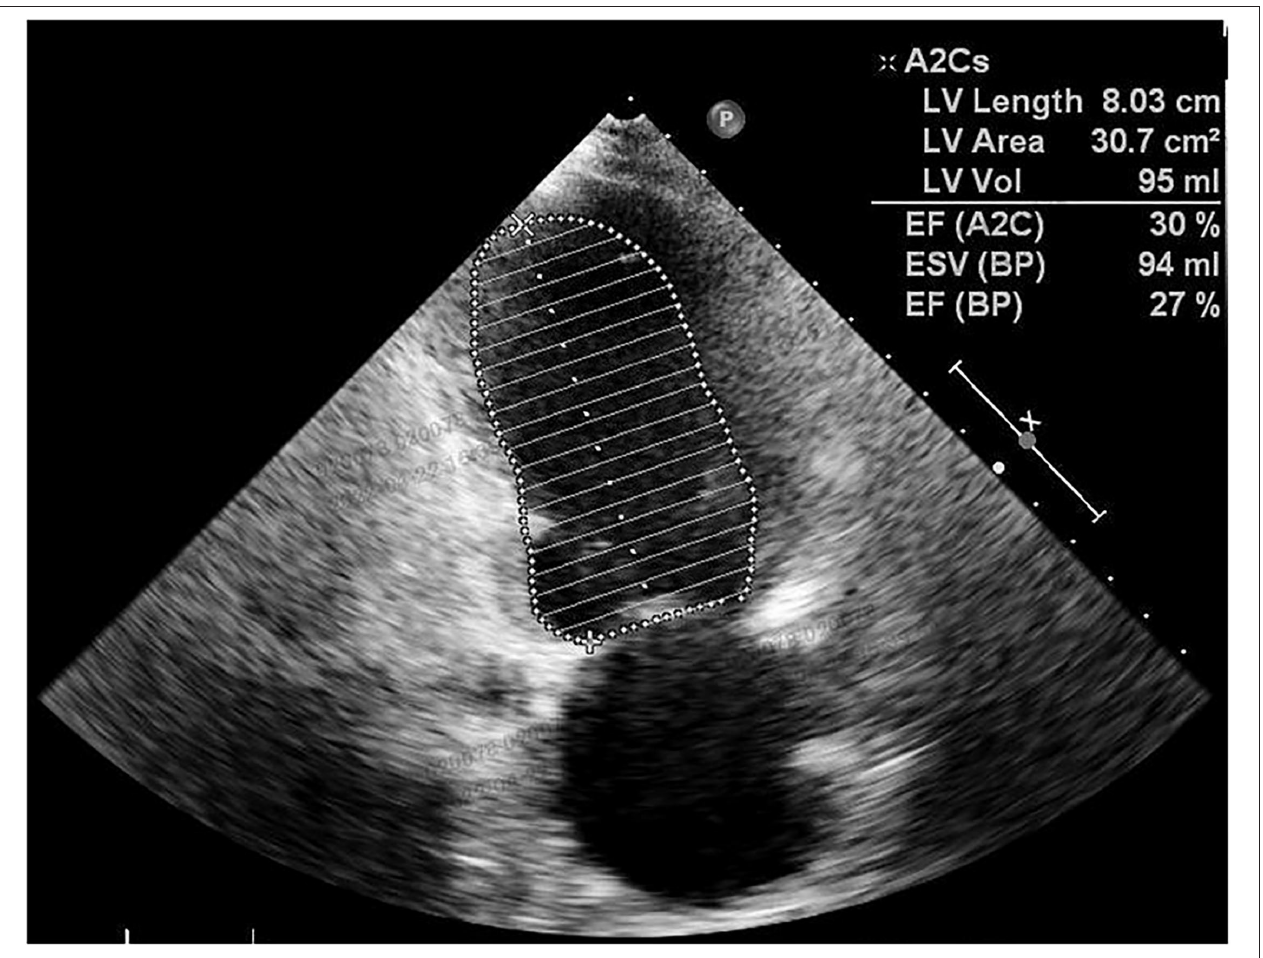
FIGURE 3 | Echocardiography performed on a postoperative Day 4 showed a remarkable decrease in